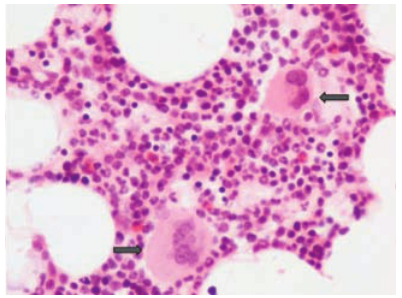
Figure 1. JAK2 -V617F mutation was detected by allele-specific PCR, as described. 2 In brief, the allele-specific polymerase chain reaction (PCR) protocol amplifies a 364 bp product (both mutant and wild-type alleles and serves as an internal control) and a 203 bp product (when the patient carries the JAK2 -V617F mutation). M: E-Gel Low Range Quantitative DNA Ladder (Invitrogen, UK). Lane 1: patient’s sample positive for JAK2- V617F mutation. Lane 2: negative control (patient with monoclonal gammopathy of undetermined significance). Lane 3: positive control (patient with polycythemia vera). Lane 4: negative PCR control. The PCR products were analyzed in 2% TBE agarose gels.